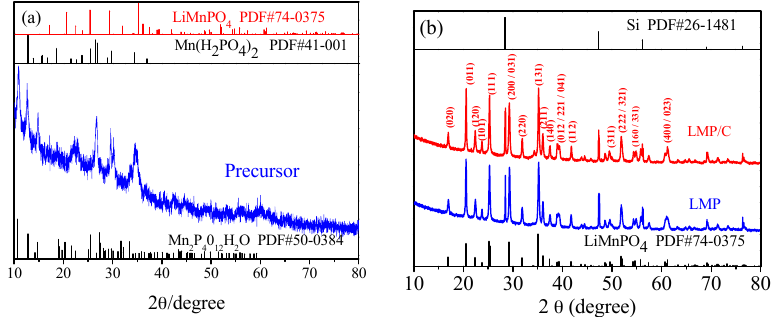
Figure 2. X-ray diffraction (XRD) pattern of ( a ) precursor; and ( b ) LiMnPO 4 (LMP) and LiMnPO 4 /C (LMP/C).